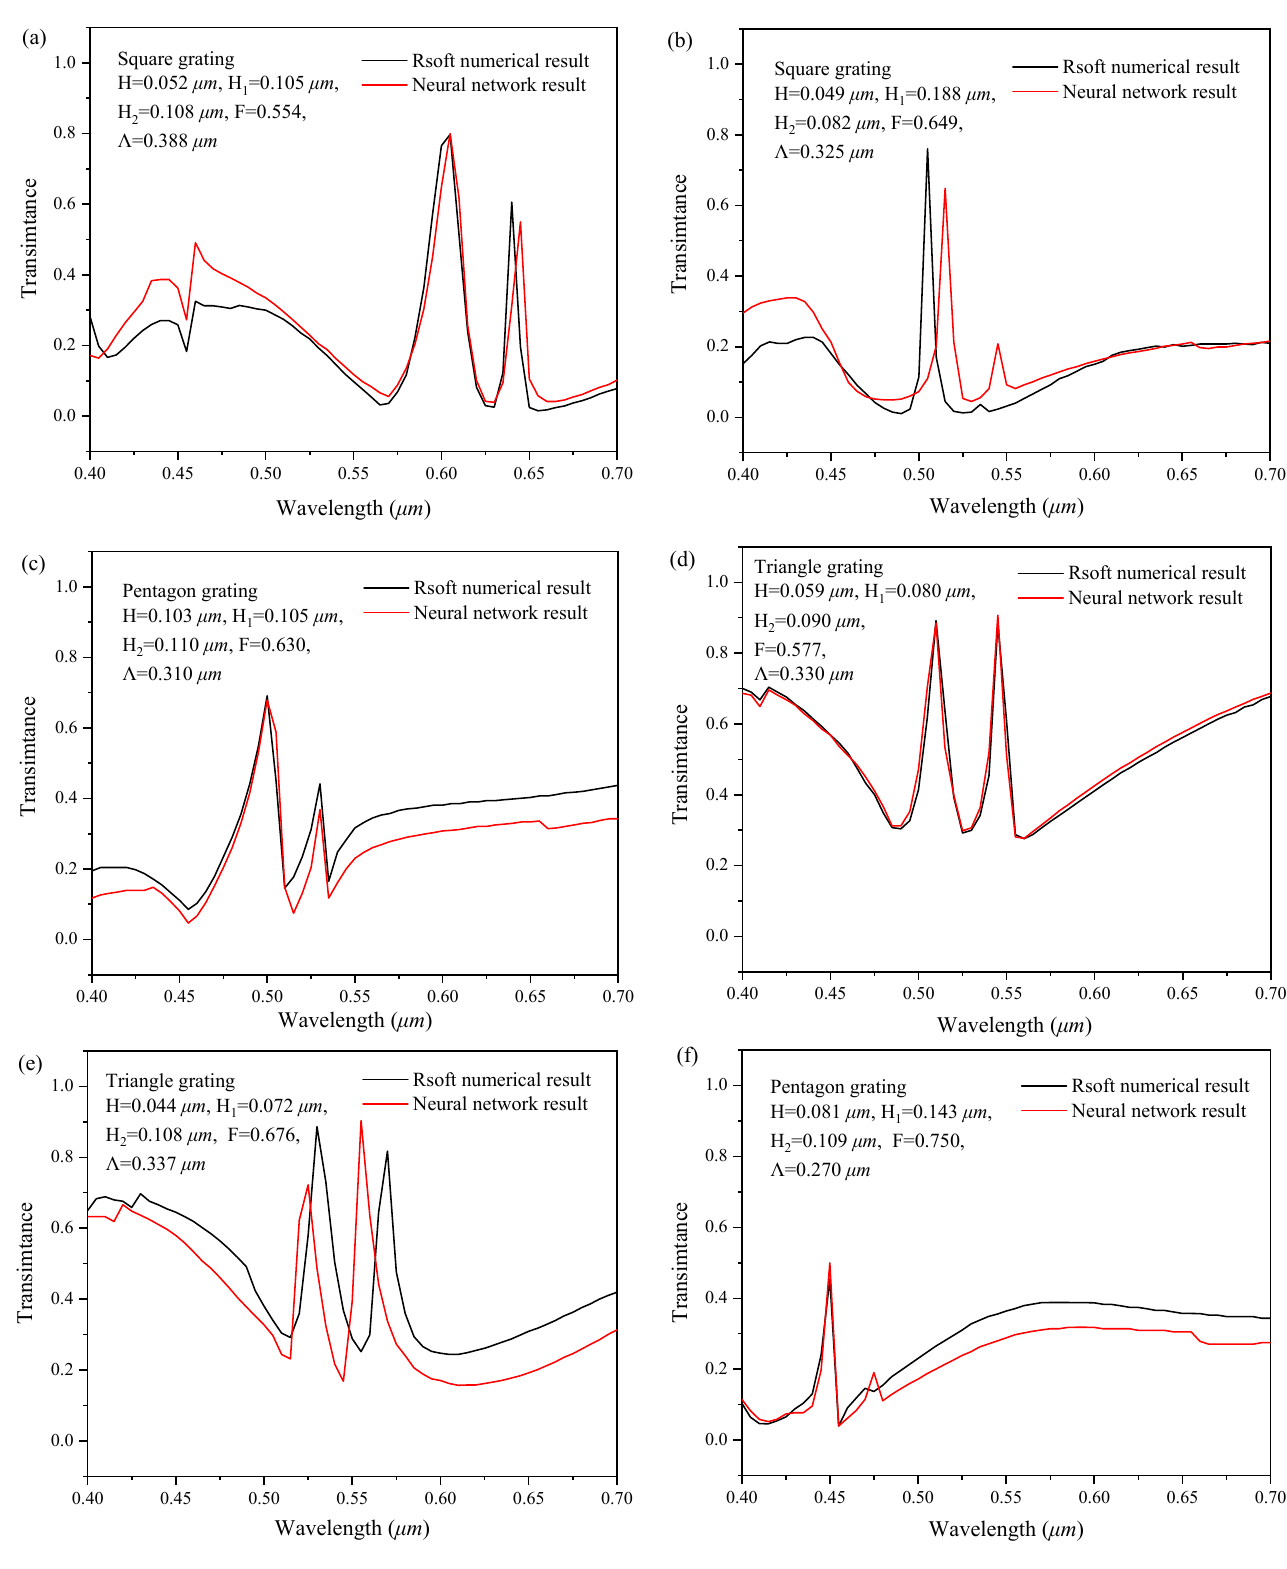
Figure 10. Validation of the inverse design, where ( a – f ) respectively represent the results of samples 1~6. The insert picture in the upper-left corner of each figure shows the designed structure parameters by the inverse network.